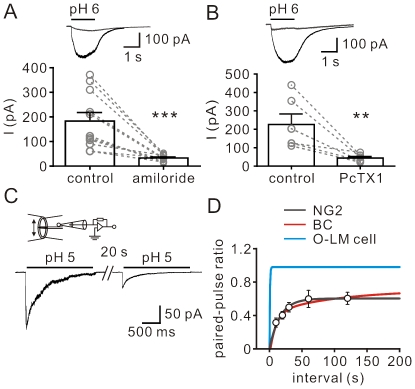
Pharmacological profile and gating of ASICs in NG2 cells.(A) Top, ASIC currents evoked by pH 6 in the control (black) and by co-application of pH 6 and 100 µM amiloride (gray). Traces in the control and in the presence of amiloride were obtained from the same cell. Bottom, summary of the effect of amiloride on ASIC currents. Data obtained from the same cell were connected by dashed lines. ***P<0.0005. (B) Top, ASIC currents evoked in the control (black) and after bath addition of PcTX1 (gray). Bottom, summary of the effect of PcTX1 on ASIC currents. **P<0.005. (C) Representative ASIC currents in a nucleated patch (V-clamped at −60 mV) evoked by double pulses (2 s, pH 5) separated by 20 s. (D) Recovery from desensitization of ASIC currents. The black curve represents a single exponential function fitted to the data points (pooled from at least 5 cells). ASIC recovery curves from BCs (red) and O-LM cells (blue) (reproduced from [24]).